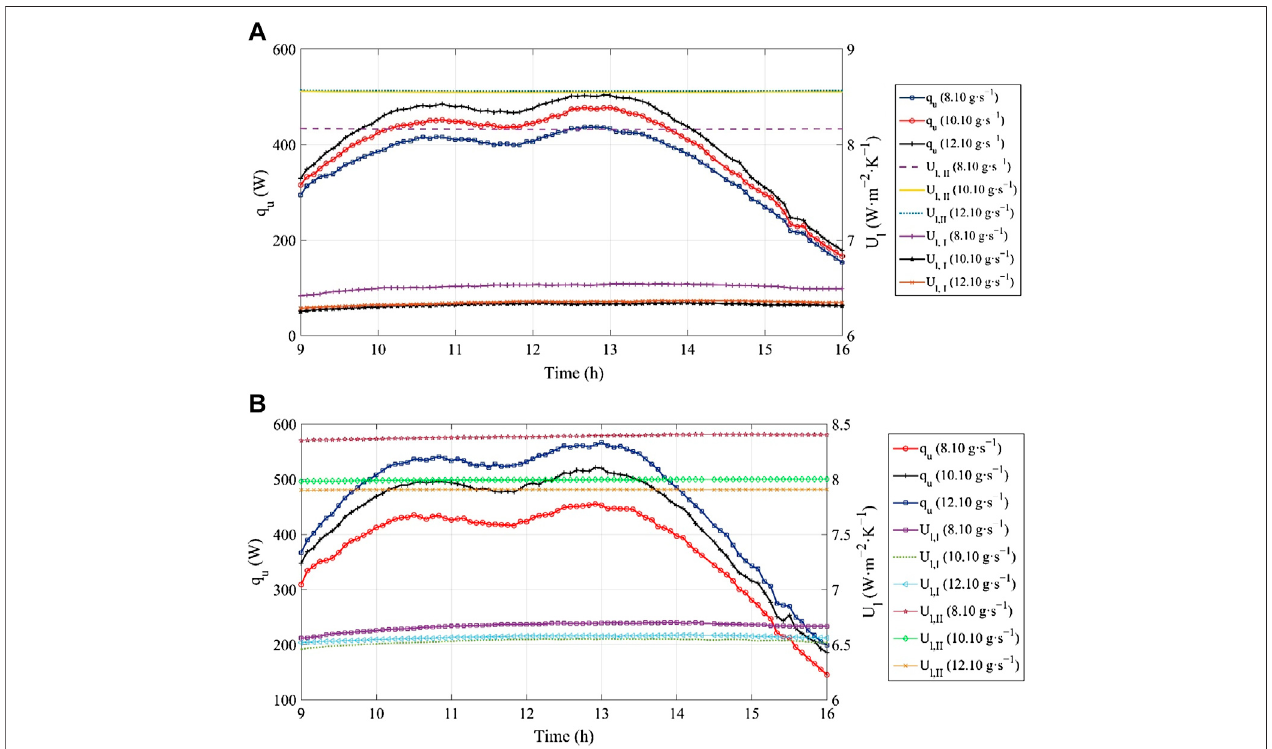
FIGURE 9 | The change in the heat gain ( q u )/overall loss coef fi cient ( U l ) with time. (A) Flat plate collector (FPC); (B) fl at plate collector with triangular fi ns (FPTF).